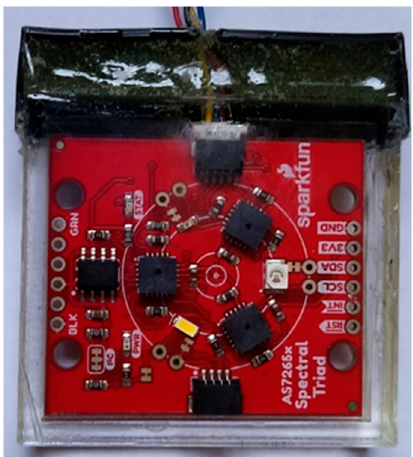
Figure 1. Unsealed acrylic boxes used for determining thickness. From left to right: 3 mm, 2.5 mm, and 2 mm. The same sensor was placed in each box and tested.